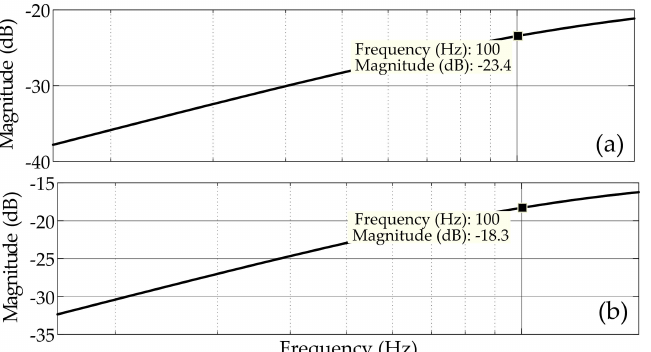
Figure 10. Bode plots of A i , cl for D = 0.47, V I = 204V, f c = 2kHz, V O = 350V: ( a ) PI controller; ( b )